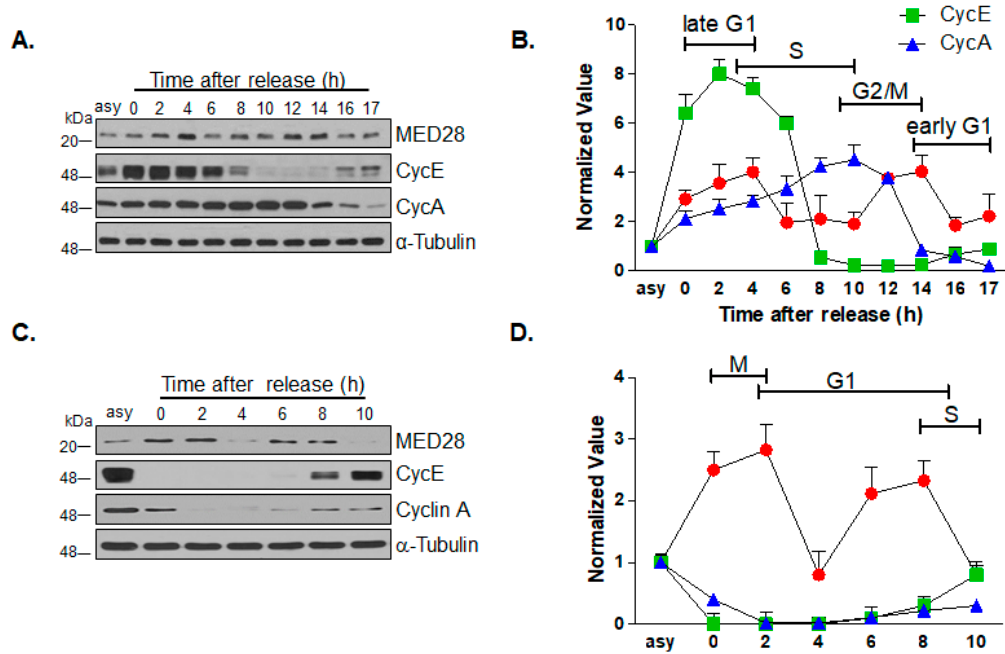
Figure 2. The changes in MED28 expression during cell cycle progression. ( A ) HeLa cells were synchronized at the G1–S transition by double thymidine (2 mM) block and then released from the arrest for the indicated times and analyzed by western blot with the respective antibodies. The expression levels of cyclin A and cyclin E were used as cell cycle markers, and tubulin was used as a loading control. The results are from at least three independent experiments are depicted ( n = 5). Asy, asynchronized. ( B ) Changes in the expression level of each protein after the release from thymidine block. The results are from at least three independent experiments are presented ( n = 5). ( C ) HeLa cells were arrested at the G2–M transition by treatment with thymidine (2 mM) and nocodazole (100 ng/mL), and then released from the arrest. The cells were harvested at the indicated time points for western blot. The expression levels of cyclin A and cyclin E were used as cell cycle markers, and tubulin was used as a loading control. Results from at least three independent experiments are depicted ( n = 5). ( D ) The change in the expression level of each protein after the release from nocodazole block. Results from at least three independent experiments are presented ( n = 5).